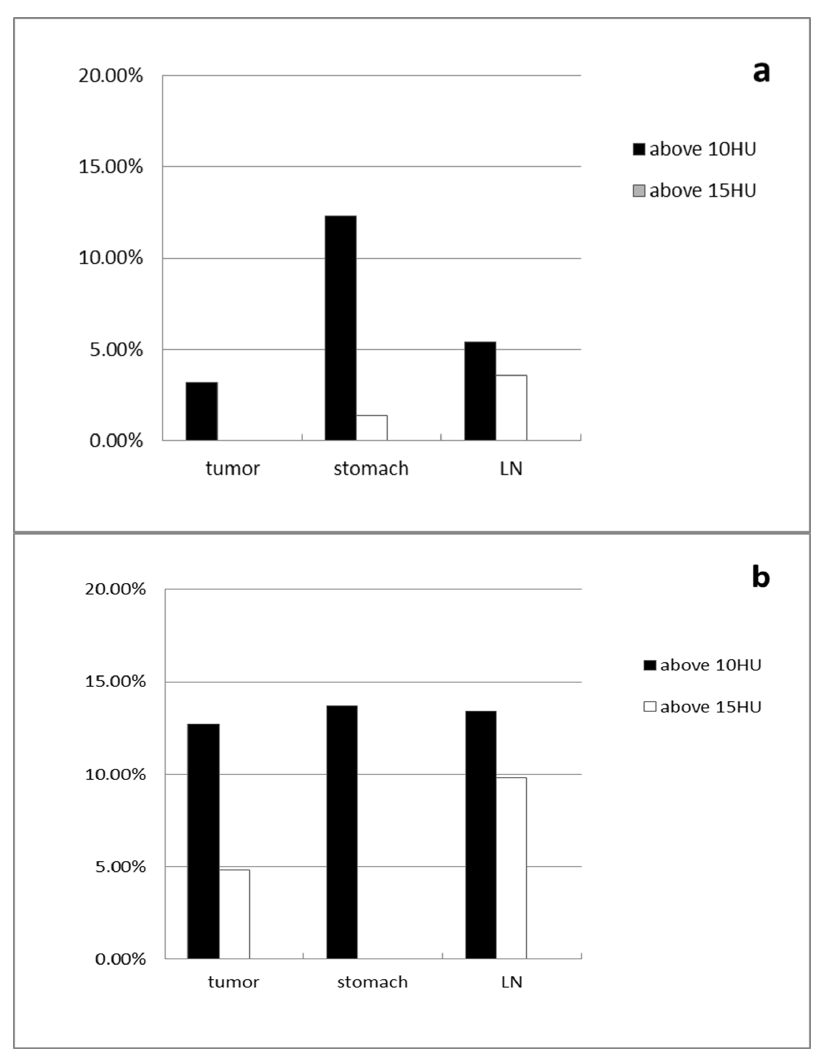
Figure 3. Proportion of measurements stratified per tissue type, with an absolute difference of . 10 and . 15 Hounsfield units between TNE and VNE images. a Proportion of measurements stratified per tissue type, with an absolute difference of . 10 and . 15 Hounsfield units between TNE and VNE A images. b Proportion of measurements stratified per tissue type, with an absolute difference of . 10 and . 15 Hounsfield units between TNE and VNE P